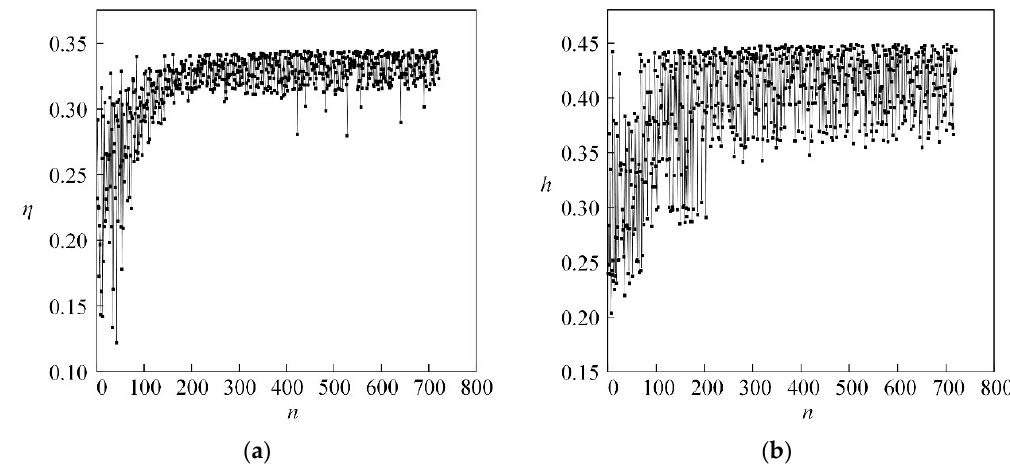
Figure 10. Trends of pump efficiency and head ratio during the searching process. ( a ) Efficiency; ( b ) head ratio.